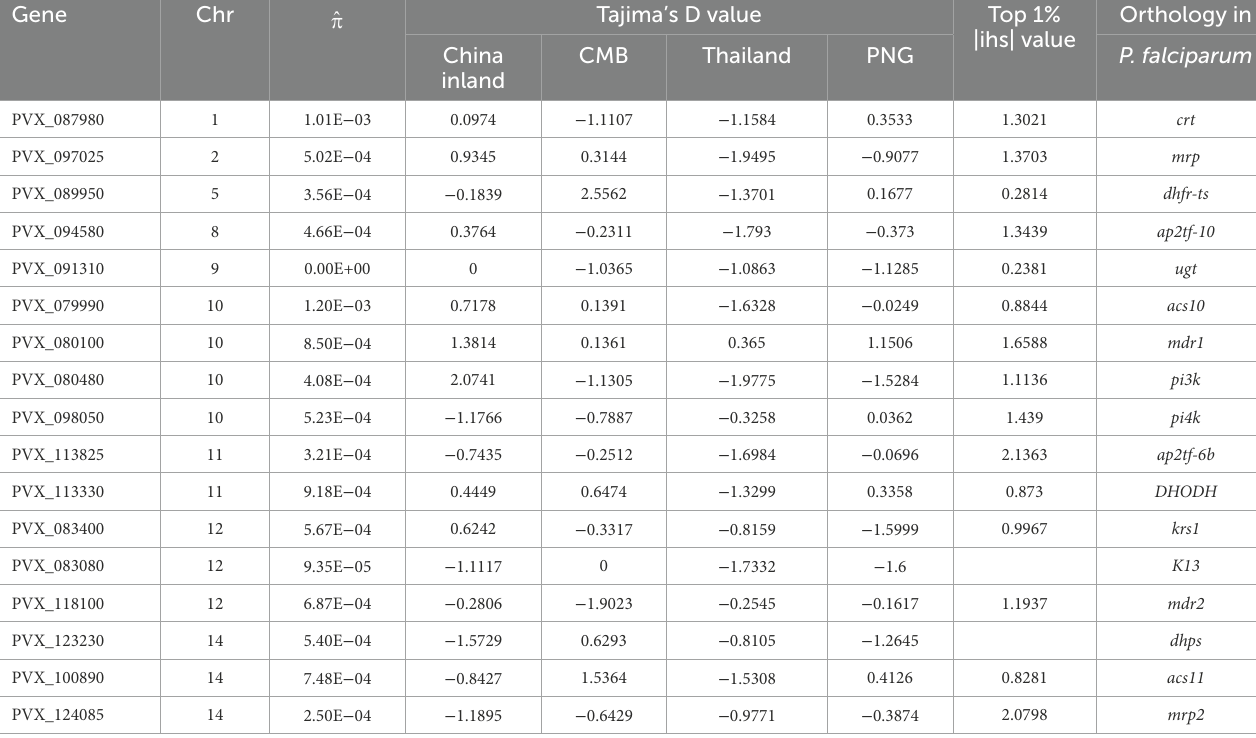
TABLE 3 Putative Plasmodium falciparum drug resistance gene orthologous with their associated population genetic statistics. Gene Chr ˆ